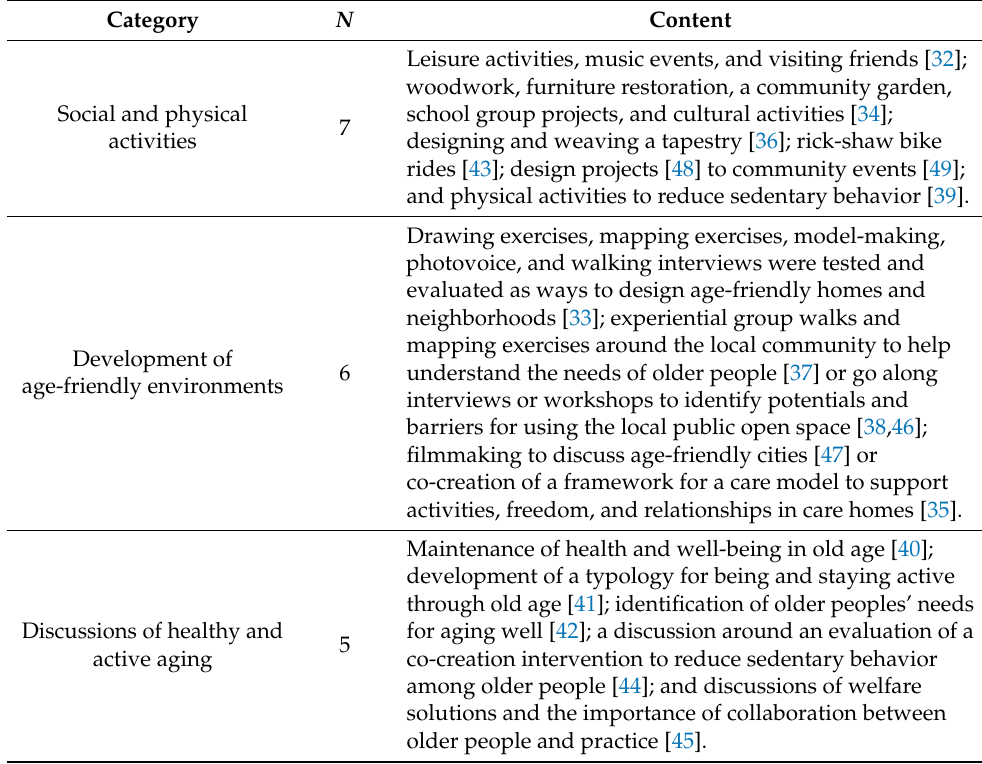
Table 1. The co-creation and co-production of